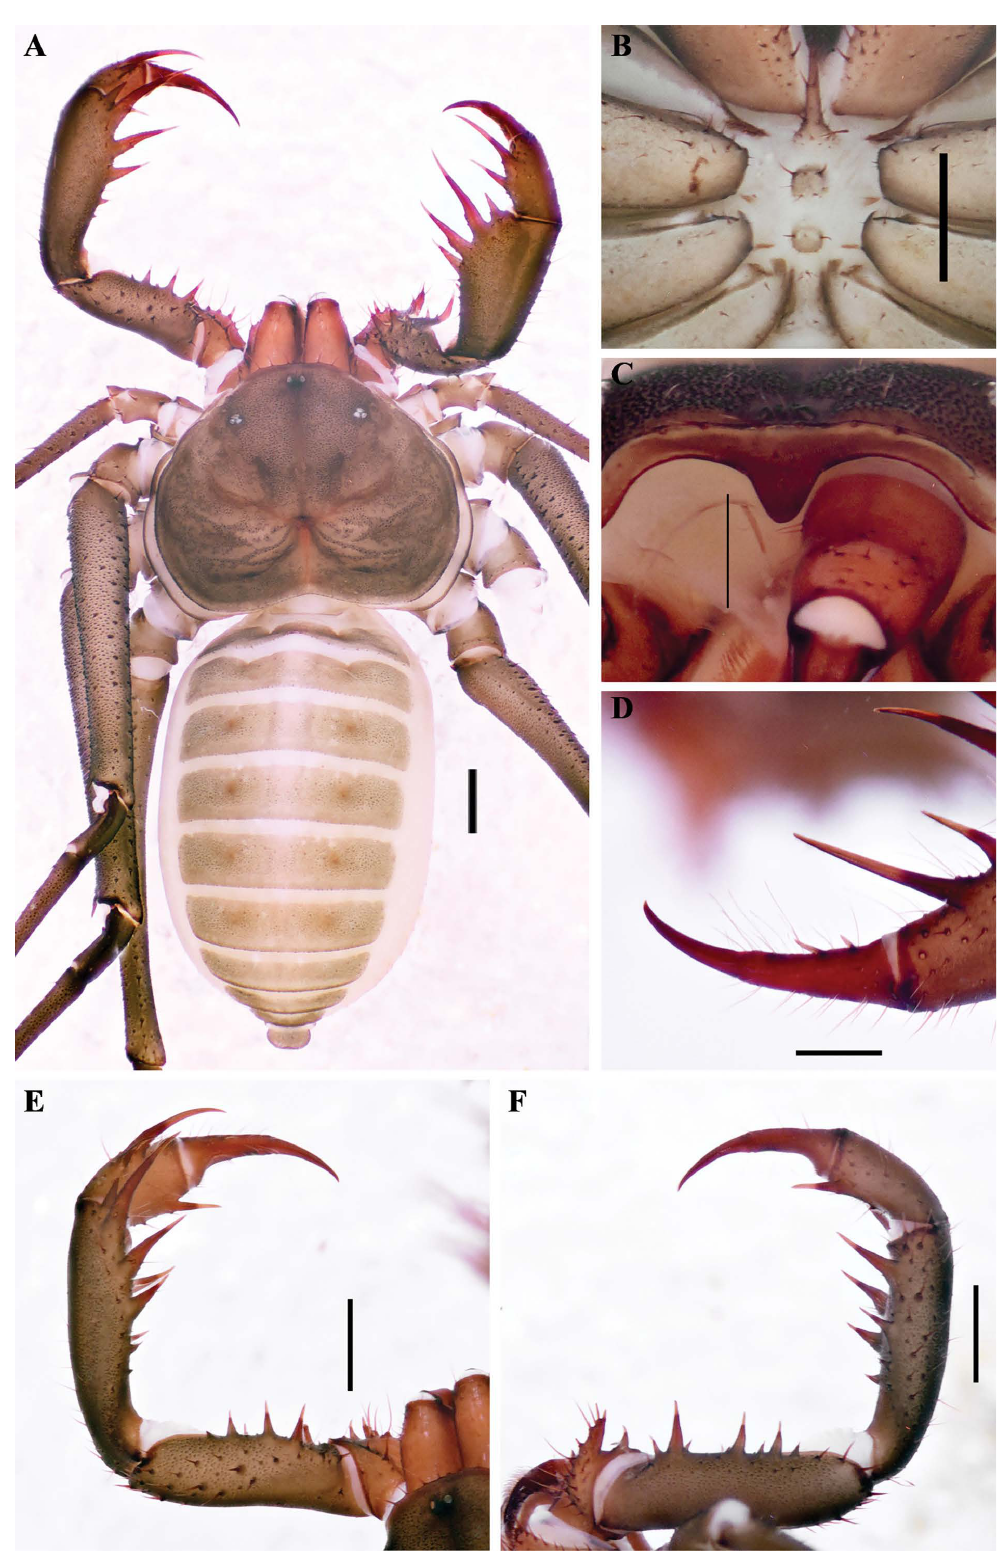
Fig. 73. Charinus renneri sp. nov. (MNRJ 9198), general morphology, ♀. A . Carapace, dorsal view. B . Sternum, ventral view. C . Frontal process. D . Pedipalp tarsus, frontal view. E . Pedipalp, dorsal view. F . Pedipalp, ventral view. Scale bars: A–B, E–F = 1 mm; C–D =